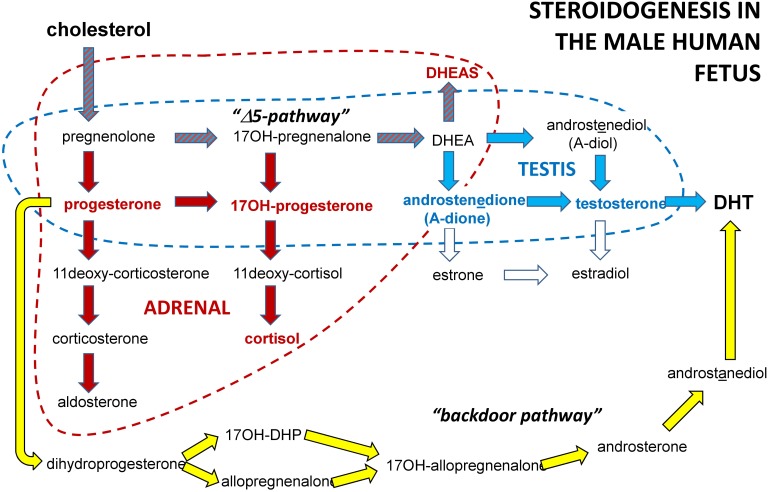
Schematic to illustrate the principal steroidogenic pathways in the male human fetus for both testes and adrenals. In bold type (red or blue) are indicated those steroids used here as biomarkers of fetal steroidogenesis.